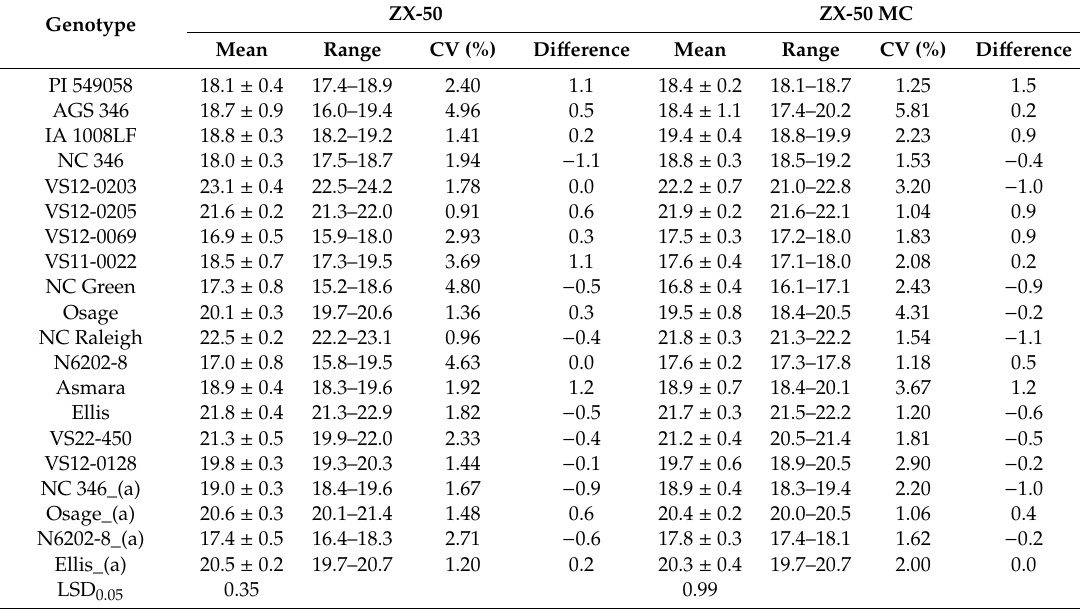
Table 5. Mean, range and coe ffi cient of variation of corrected oil content (g 100 g − 1 ) determined